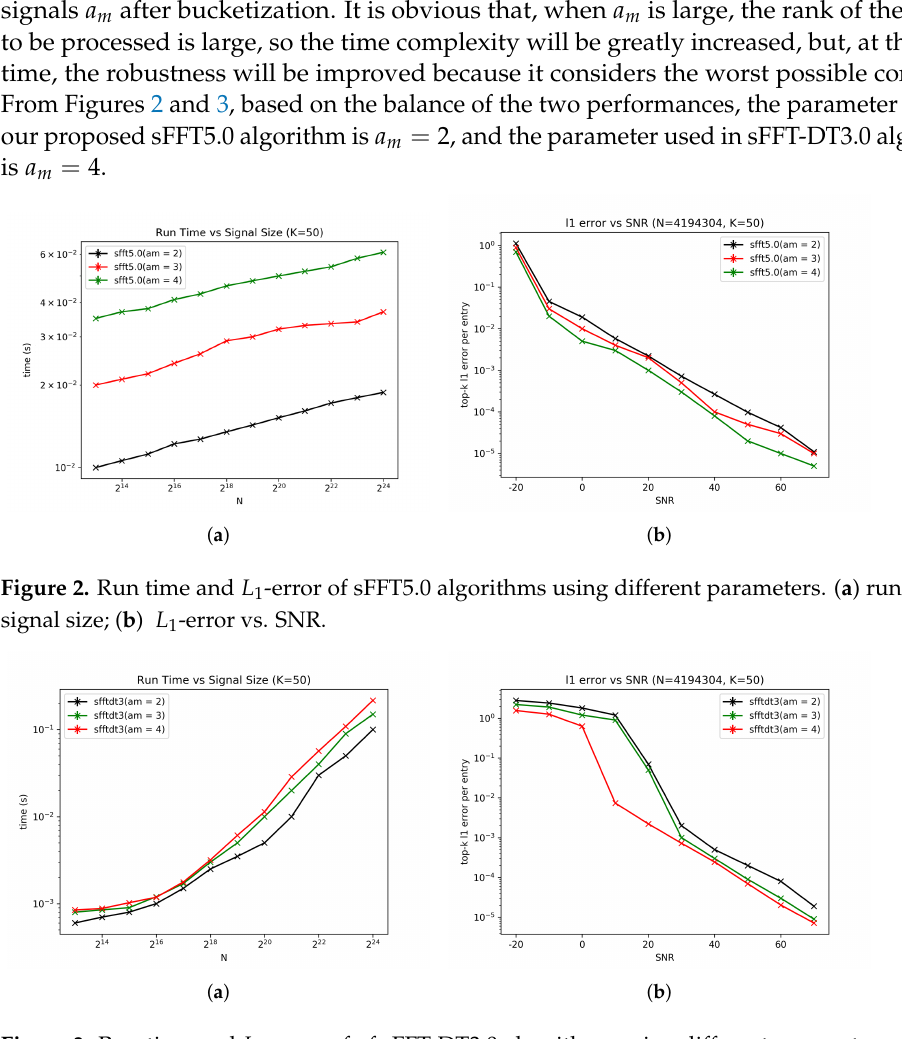
Figure 3. Run time and L 1 -error of of sFFT-DT3.0 algorithms using different parameters. ( a ) Run time vs. signal size; ( b ) L 1 -error vs.